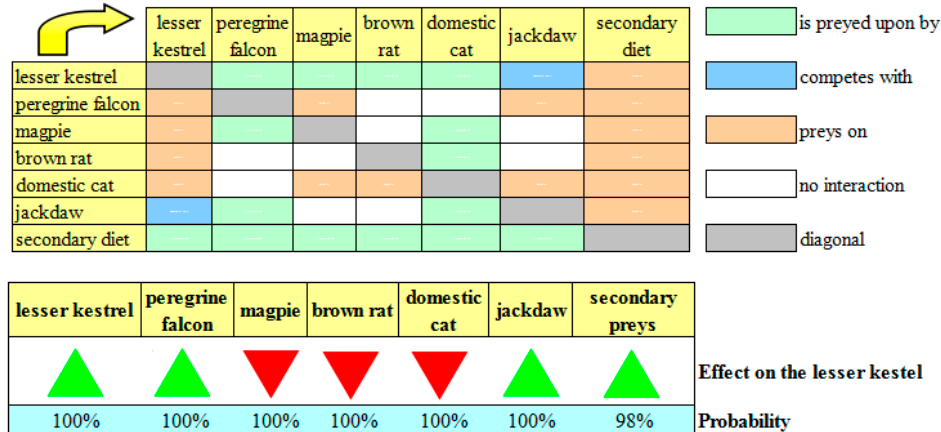
Figure 5. ( Top ) The community matrix of the lesser kestrel in the Alta Murgia for the “secondary prey” scenario. The matrix must be read from the rows to the columns. ( Bottom ) Table of predictions. Key to reading: an increase in the growth rate of the brown rat will result in a decrease in the lesser kestrel population stock, with probability equal to 100%. In the case of negative inputs (e.g., a decrease in the growth rate of the brown rat), the predicted effects on the lesser kestrel population stock must be inverted, but the probabilities remain unchanged.